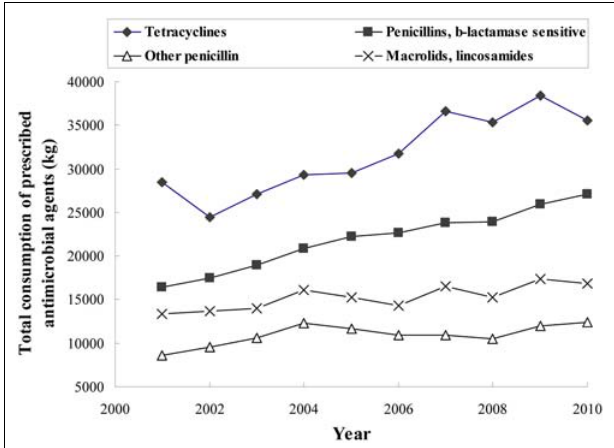
FIGURE 1 | Estimated total consumption (kg) of prescribed antimicrobial agents for production animals in Denmark (data obtained from DANMAP,